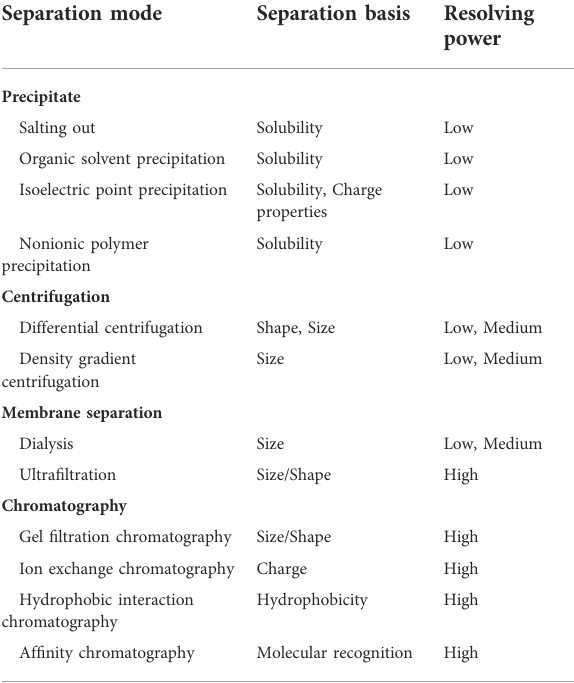
TABLE 2 Separation basis and resolution of several puri fi cation methods (Labrou,